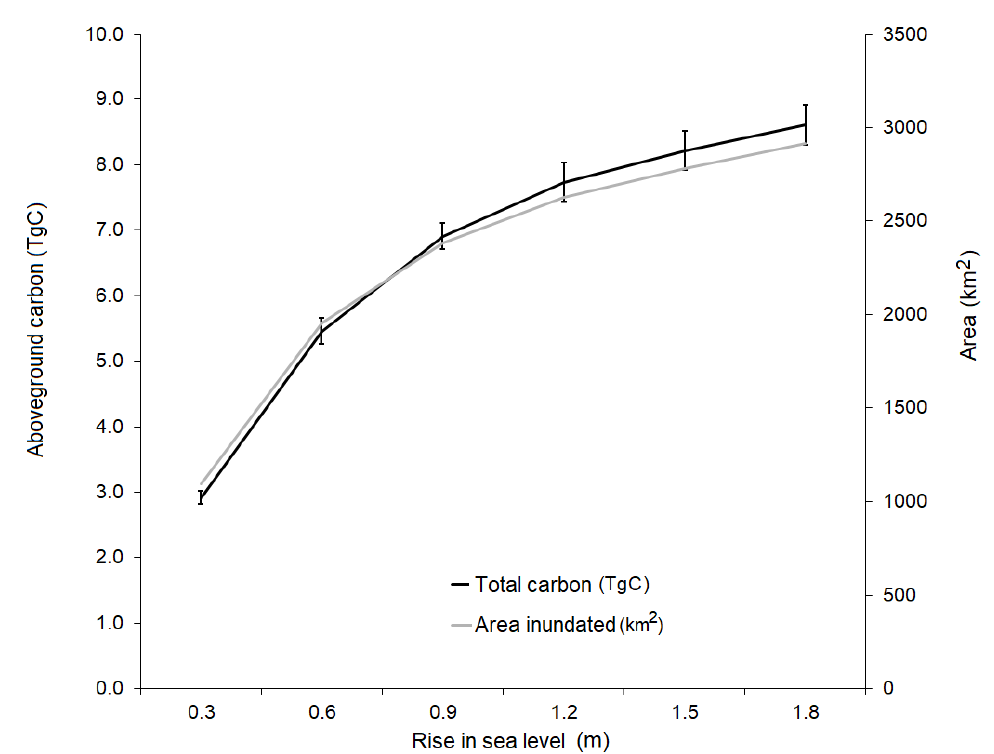
Figure 7. Total area (km 2 ) inundated (grey line; right axis) and total aboveground carbon, measured in teragrams of carbon (TgC), lost (black line; left axis) and associated standard errors from sea level rise inundation. The sea level rise inundation model, from the National Oceanic and Atmospheric Administration, represents inundation under the intermediate–high sea level rise (slr) scenario (ranging from 0.3 to 1.8 m) or Representative Concentration Pathway 8.5.